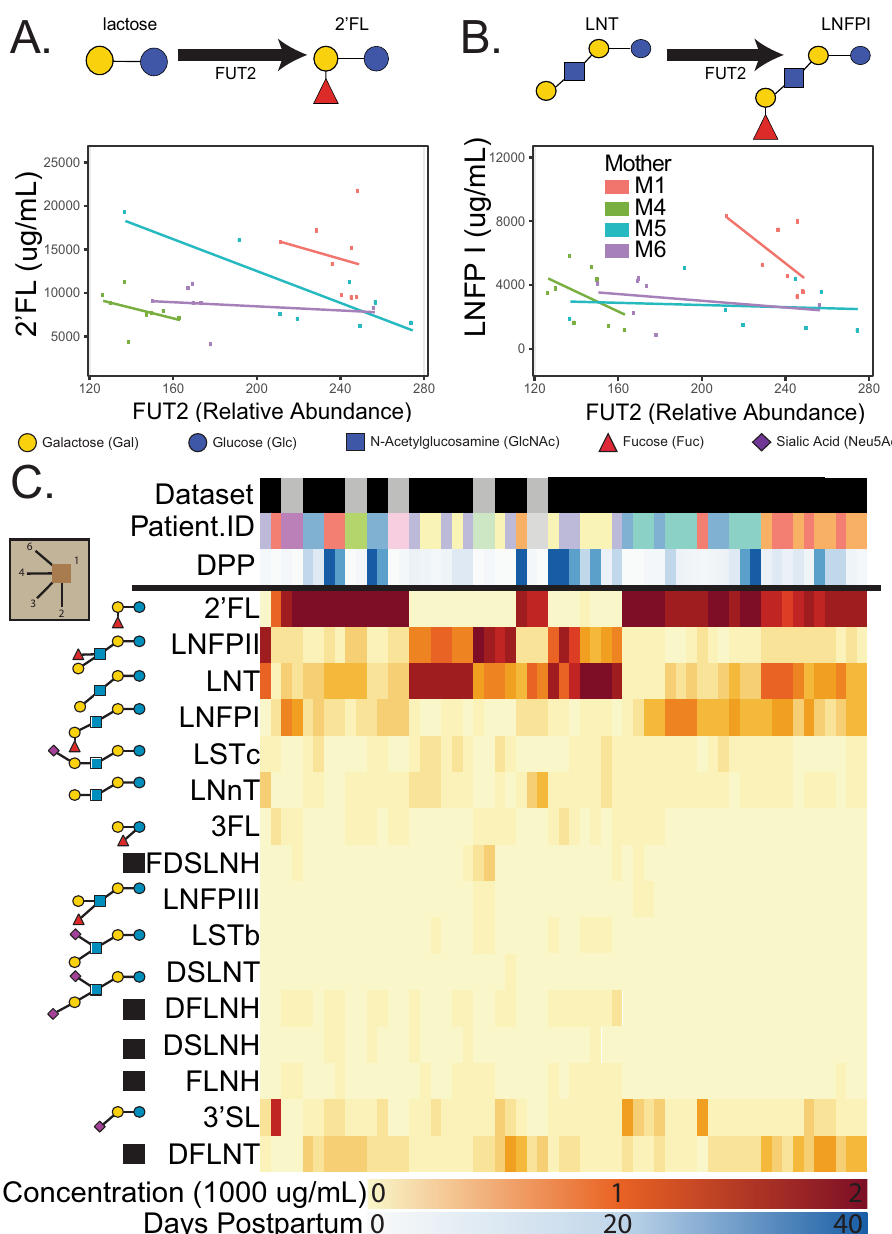
Fig. 2 FUT2 expression should increase 2 ′ FL and LNFPI which require the enzyme but there is no signi fi cant positive association. A concentration heatmap for all HMOs is shown below. Direct comparison of FUT2 gene expression and concentrations (nmol/mL) of α -1,2-fucose containing HMOs, 2 ′ FL ( A ) and LNFPI ( B ), in sample-matched microarray and absolute HMO abundances reveal no signi fi cant association in secretor women from cohort 1 sampled between day 1 and 42 postpartum. The linear trends were drawn to illustrate poor HMO-gene correlations. Trendlines and points are colored by subject. Linear trends were used to illustrate the intuition of the GEE approach used to estimate these associations across subjects. Non-secretor mothers were excluded due to non-functional FUT2. C A heatmap of all HMO concentrations across cohort 1 and cohort 2 (top-bar black and gray respectively). Known HMO structures 2 are shown to the left of each row while undetermined structures are indicated with a black box. For literature curated 6,8,33,104,108,109 isomers of undetermined structures, see Supplementary Fig.